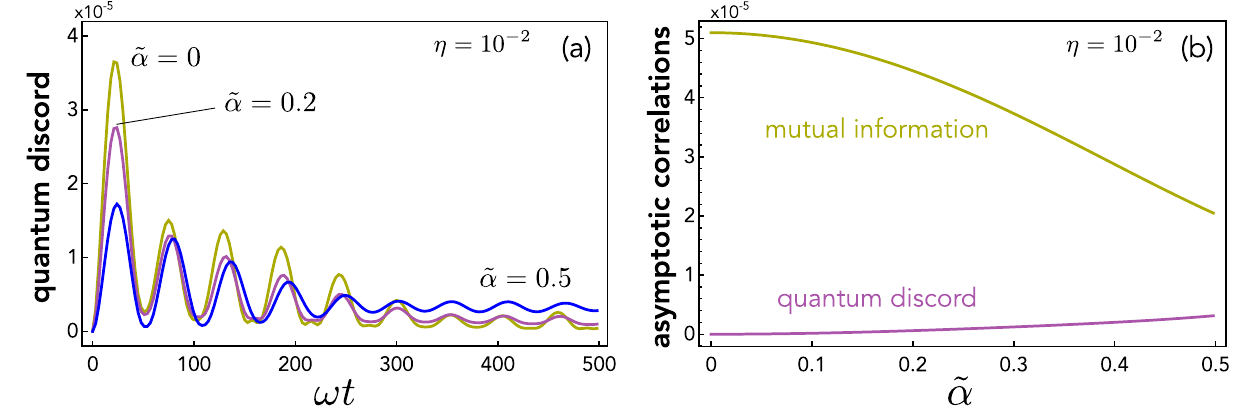
1 ) when α (this must be small in ˜ 2 10 α . In both panels we set η . Discord D was − ˜ =